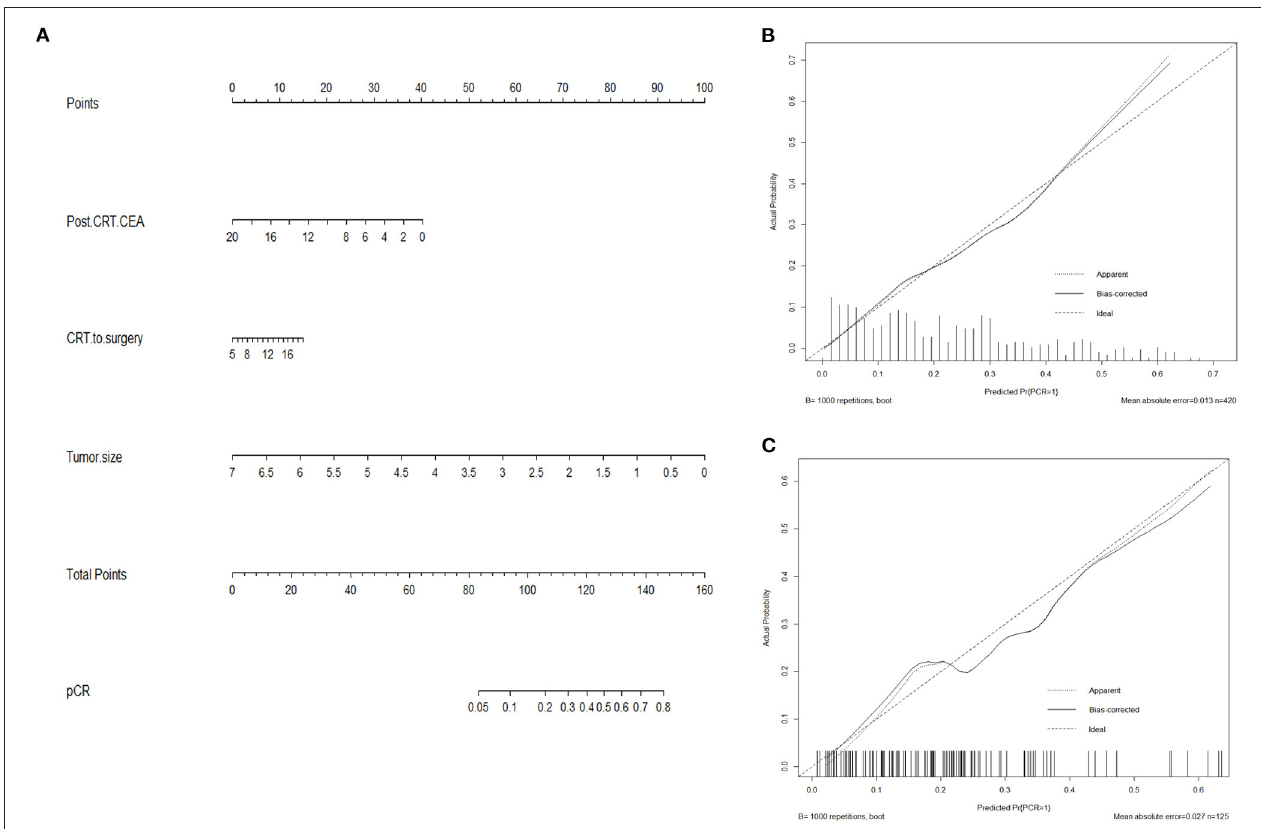
FIGURE 3 | Nomogram predicting pCR (A) and calibration curves with internal (B) and external (C) validation. (A) A score for each variable can be obtained at the top scale, and the sum of scores indicates a predictive probability of pCR. (B,C) The solid line indicates the actual performance of our nomogram, and the dashed line represents the prediction by an ideal model. CEA, carcinoembryonic